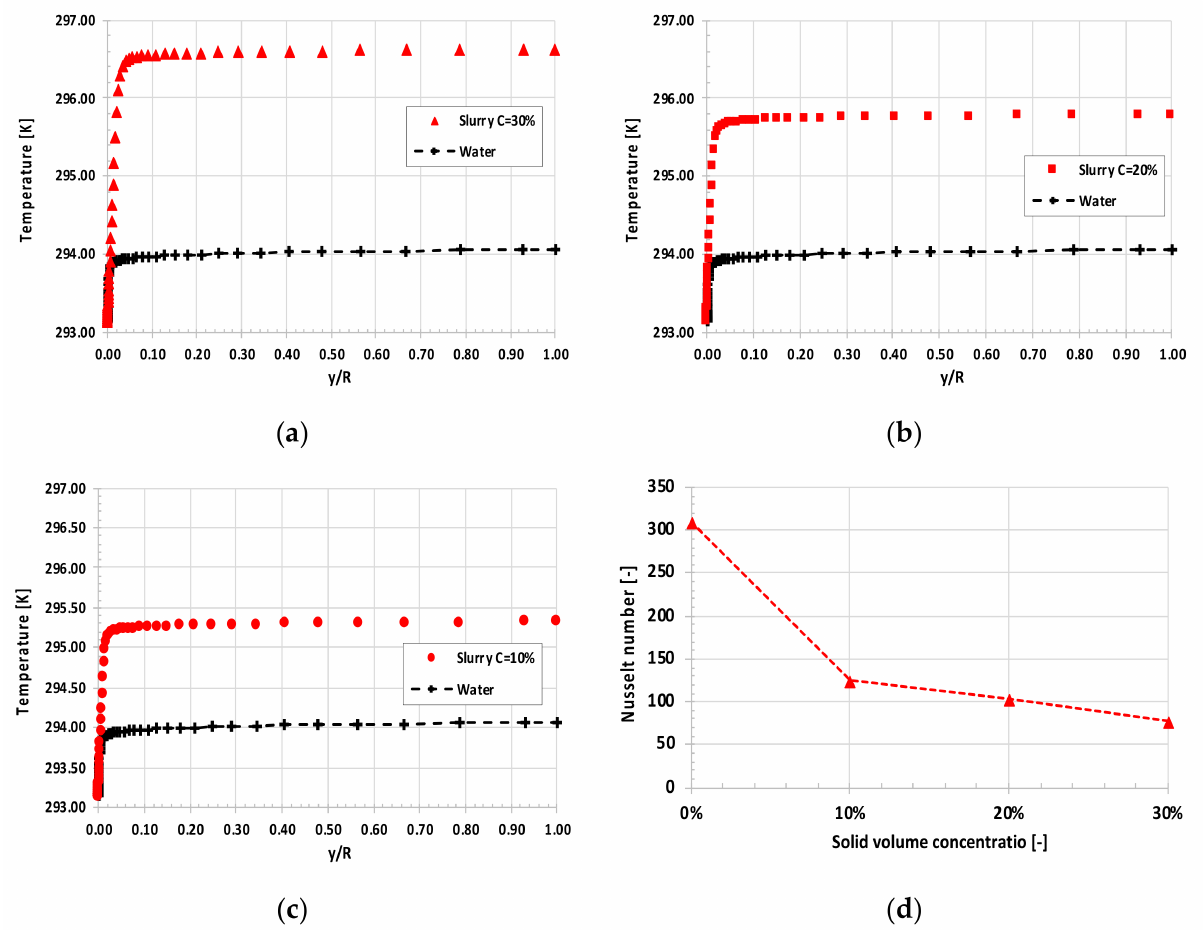
Figure 4. ( a ) Comparison of temperature profiles for slurry and water; C = 30%, U b = 3.50 m/s; q = − 500 W/m. ( b ) Compar- ison of temperature profiles for slurry and water; C = 20%; U b = 3.50 m/s; q = − 500 W/m. ( c ) Comparison of temperature profiles for slurry and water; C = 10%; U b = 3.50 m/s; q = − 500 W/m. ( d ) Influence of solid concentration on the Nusselt number; U b = 3.50 m/s; q = − 500